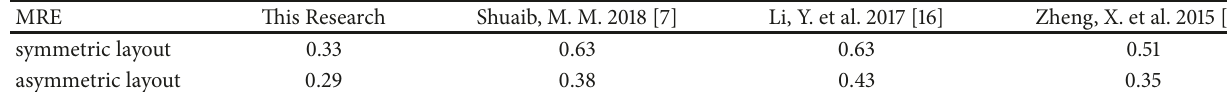
Table 4: The values of MRE by different algorithms.